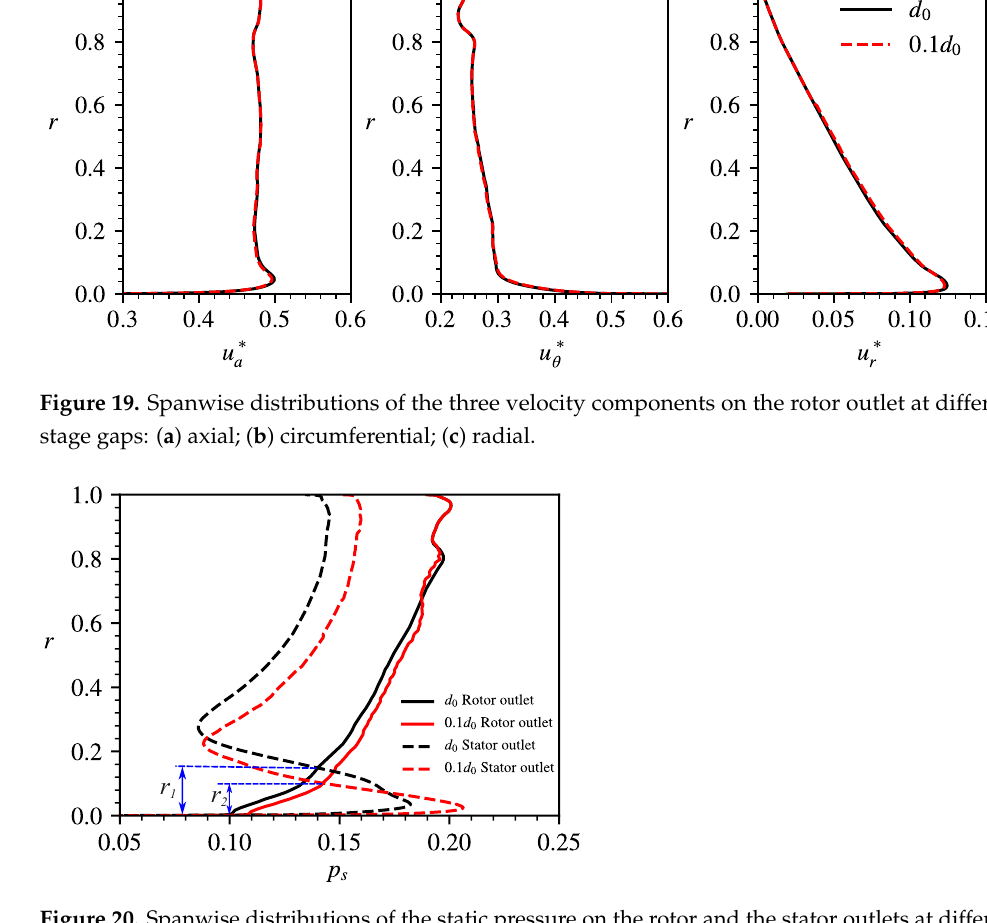
Figure 20. Spanwise distributions of the static pressure on the rotor and the stator outlets at different stage